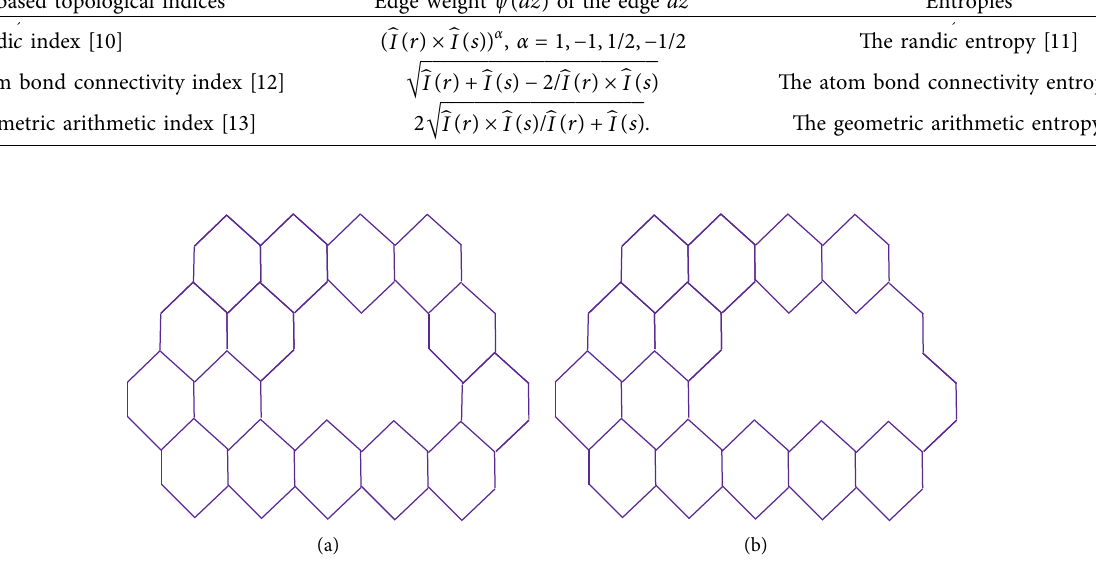
Table 1: Degree-based topological indices together with their corresponding edge weight ψ ( az ) of the edge az . Degree-based topological indices